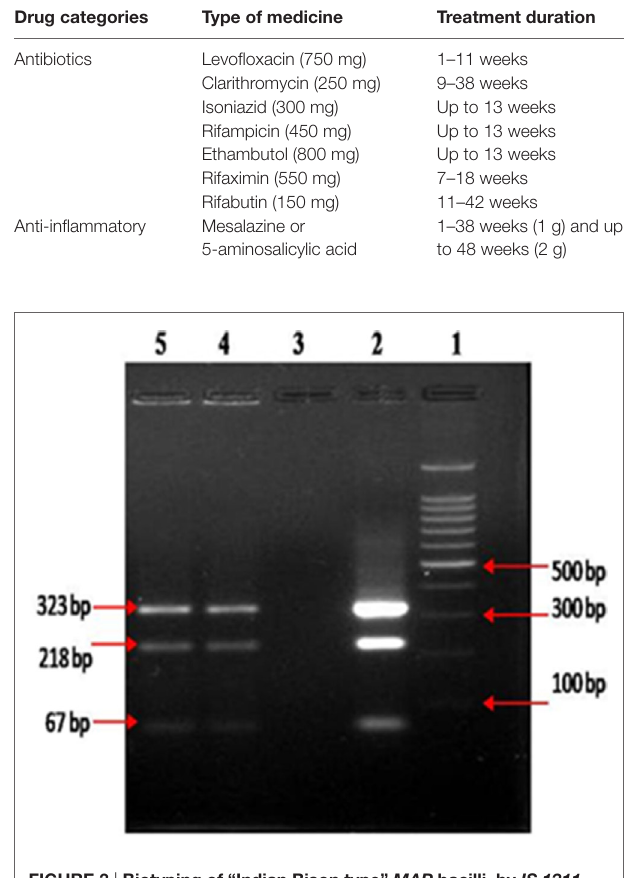
FIgURe 3 | Biotyping of “Indian Bison type” MAP bacilli, by IS 1311 pCR_Rea, from colonies developed at the end of 12 months of culture on HeY medium, columns 4 and 5 .